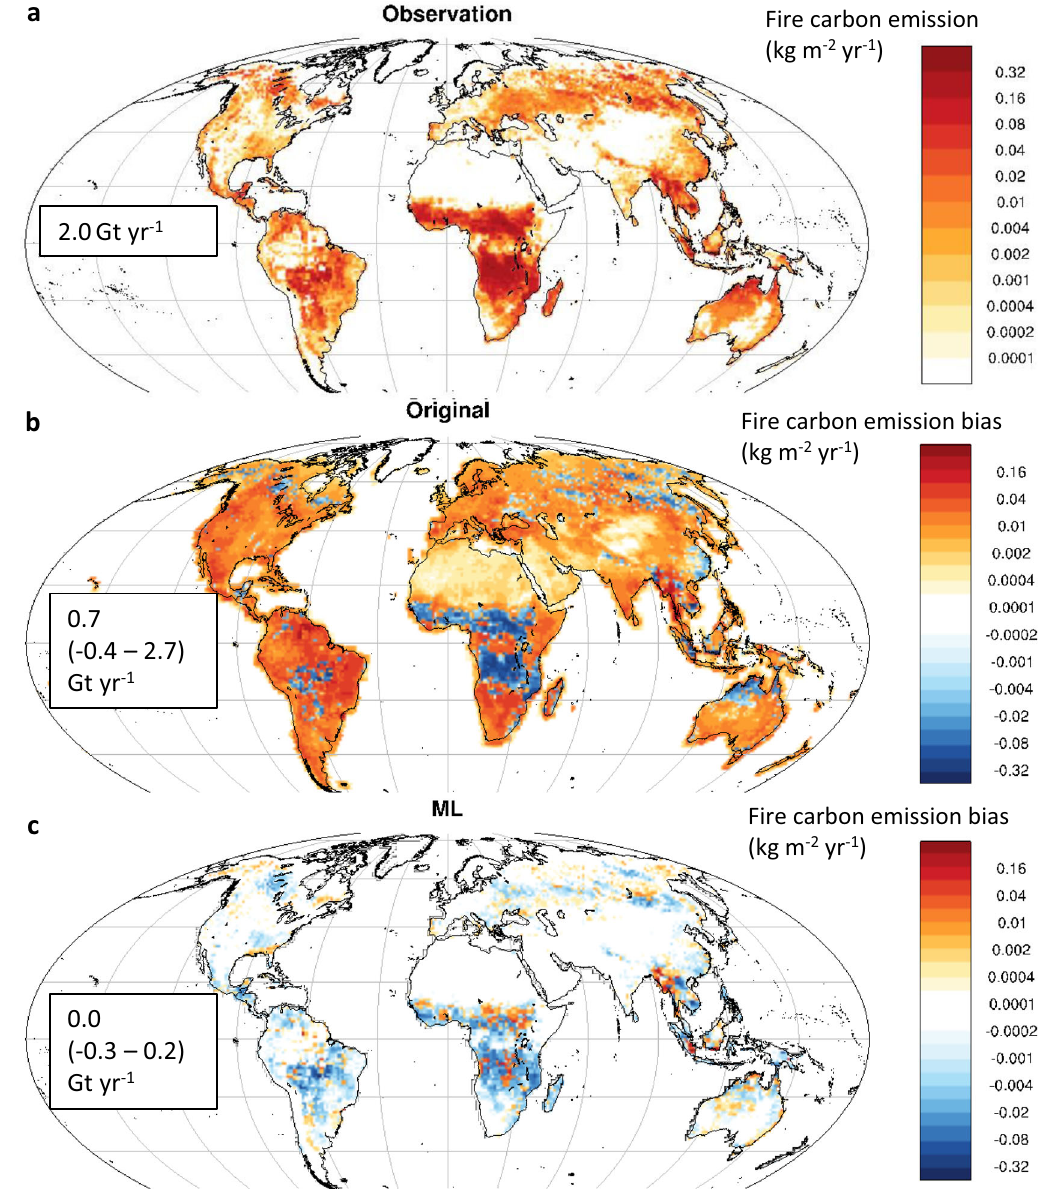
Fig. 1 Historical fi re carbon emissions during 2007 – 2016 simulated by 13 Earth system models (ESMs) without and with the observational constraint. a Observed mean fi re carbon emissions (kg m − 2 yr − 1 ), averaged across two observational data sets. The global total fi re carbon emission and its uncertainty range is marked. b Spatial distribution of the bias in original, unconstrained multimodel mean fi re carbon emissions (kg m − 2 yr − 1 ). c Spatial distribution of the bias in observation-constrained multimodel, multi – data set mean fi re carbon emissions (kg m − 2 yr − 1 ). The bias of global total fi re carbon emission and its uncertainty range (10th – 90th percentiles) is marked in the corresponding panels b , c